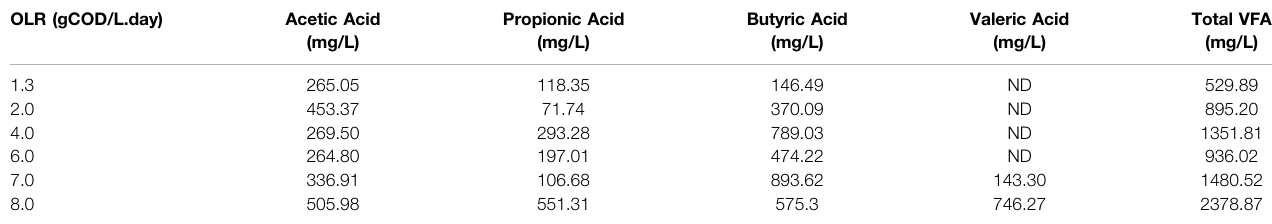
TABLE 6 | Volatile fatty acids. OLR (gCOD/L.day) Acetic Acid